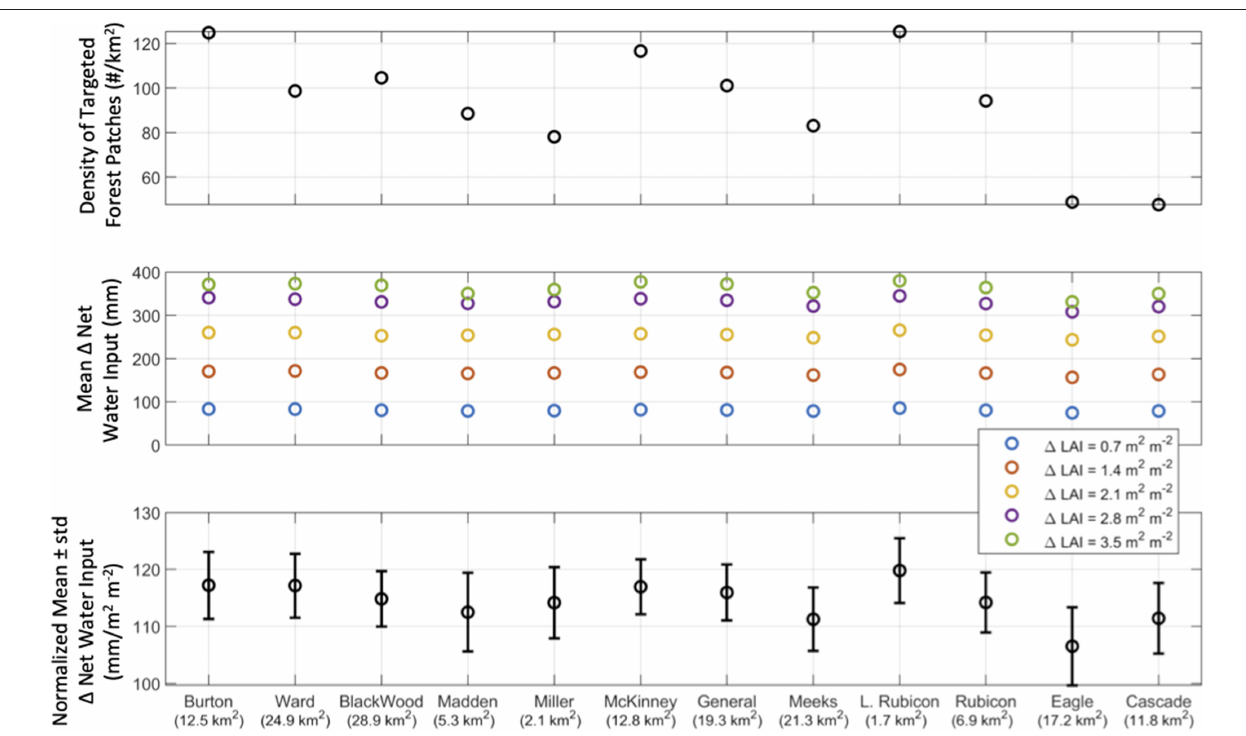
FIGURE 13 | Upper panel: density of targeted forest patches (LAI > 3 m 2 /m 2 and height between 5 and 15m) across 12 watersheds on the west shore of Lake Tahoe. Center panel: expected change to net water input for the targeted forest patches and each thinning scenario. Lower panel: mean and standard deviation of the expected normalized changes to net water input. Watersheds in the X-axis are sorted from north to south (left to right) and the drainage area is also presented for